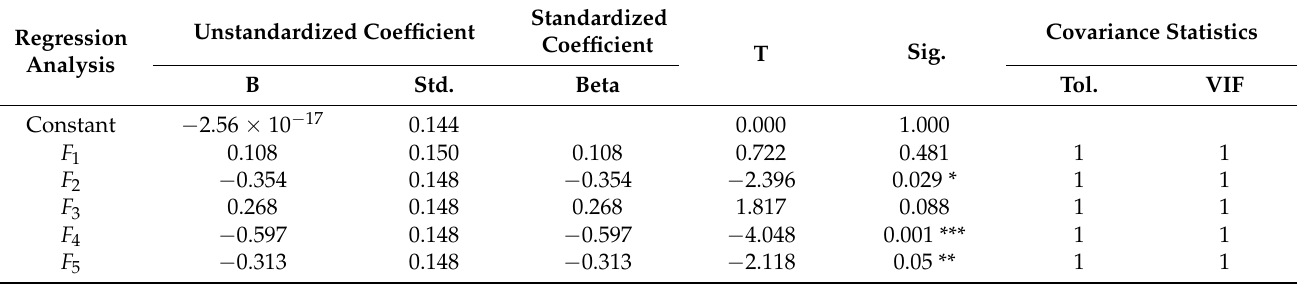
Table 6. Multiple linear backward stepwise regression analysis based on a principal component